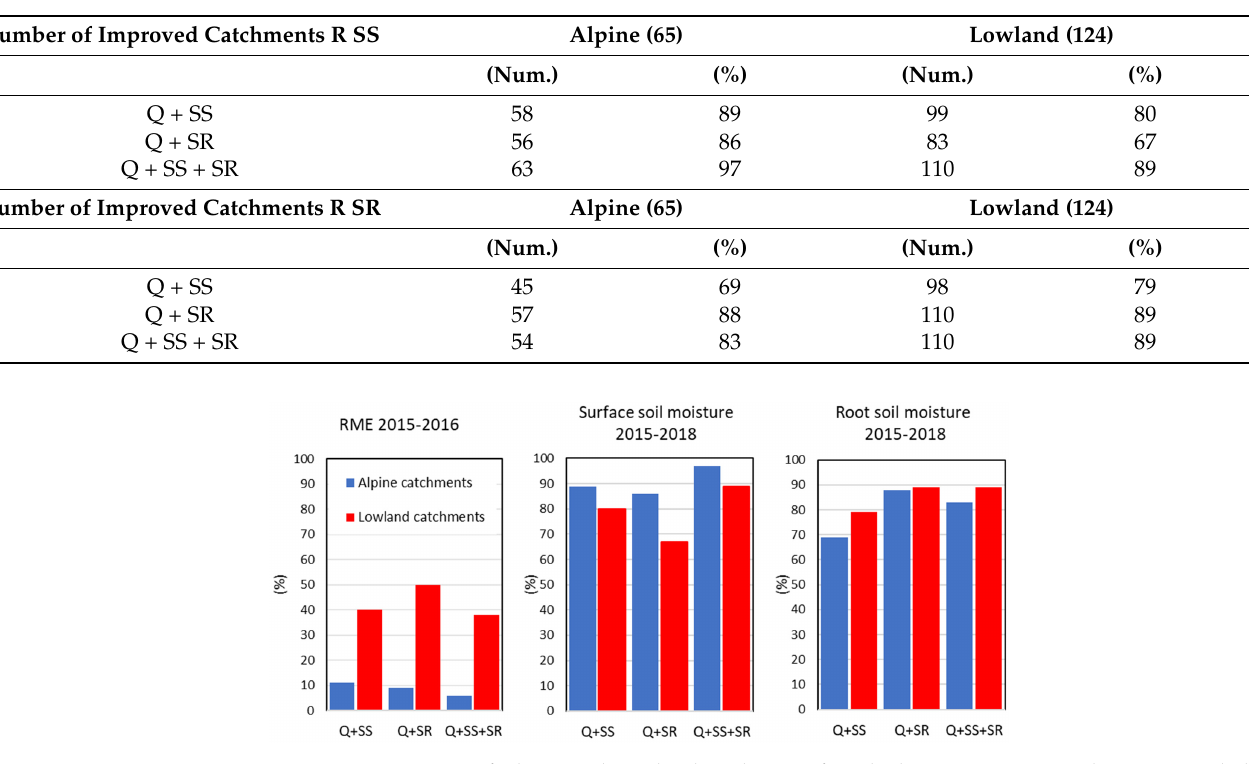
Table 8. Correlation coefficients between the simulated and measured soil moisture in the surface and root soil layers for 189 catchments in the validation period 2015–2018, and comparison of the number of improved Alpine (65) and Lowland (124) catchments in the correlation coefficients.